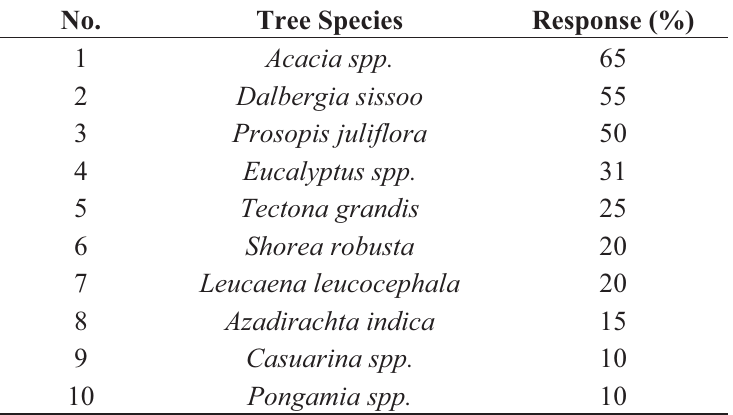
Table 4. Suitable tree species for energy wood plantation on wasteland ( N = 31). No.